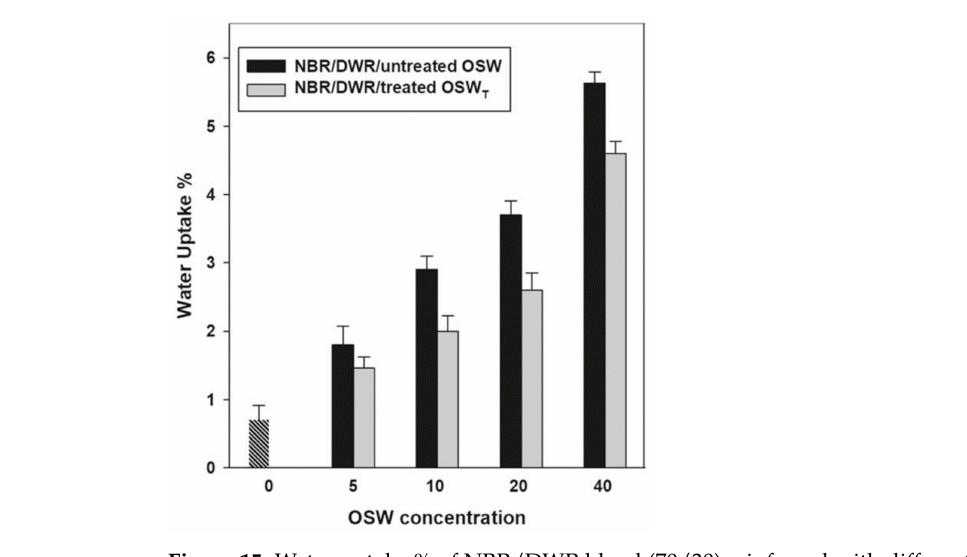
Figure 15. Water uptake % of NBR/DWR blend (70/30) reinforced with different concentrations of (treated or untreated) olive stones waste [68].